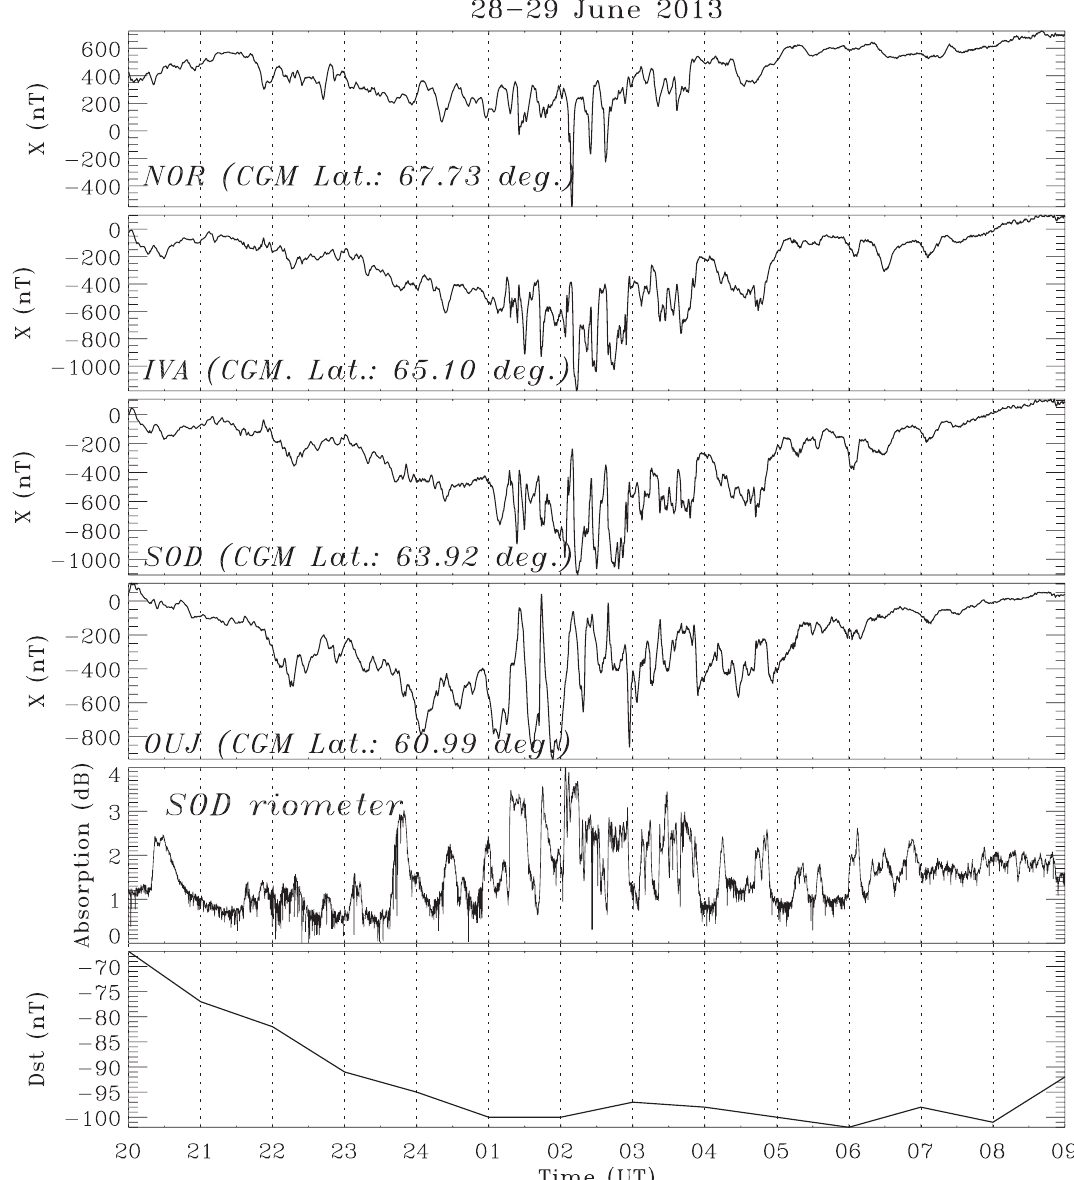
Fig. 11. X component [nT] of geomagnetic fi elds at the latitudinal array of stations NOR, IVA, SOD, and OUJ (10-s data) during the magnetic storm between 20 UT on 28 June 2013 and 09 UT on 29 June 2013. The fi fth panel shows the riometer absorption [relative units] at station SOD (10-s data). The bottom panel shows hourly Dst index [nT]. Geomagnetic latitudes are indicated near the station